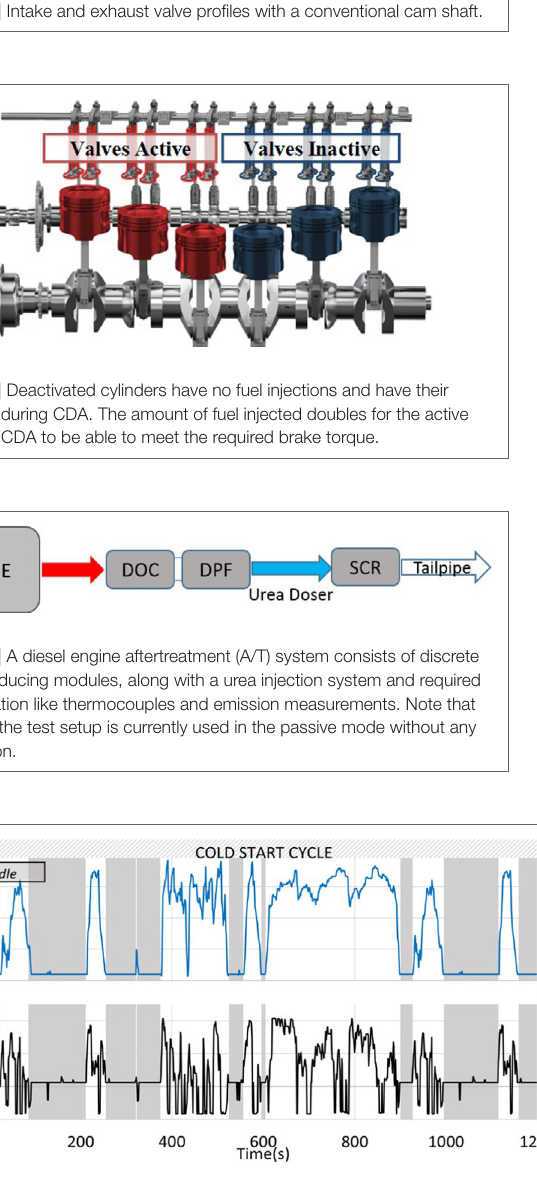
FigUre 6 | Speed and torque profiles for the HD-FTP show that nearly 40% of the HD-FTP operation occurs at idle conditions. Shaded gray areas highlight the idle (800 RPM/1.3 bar) sections while correspond to BMEP < 3 bar where CDA can potentially be implemented.